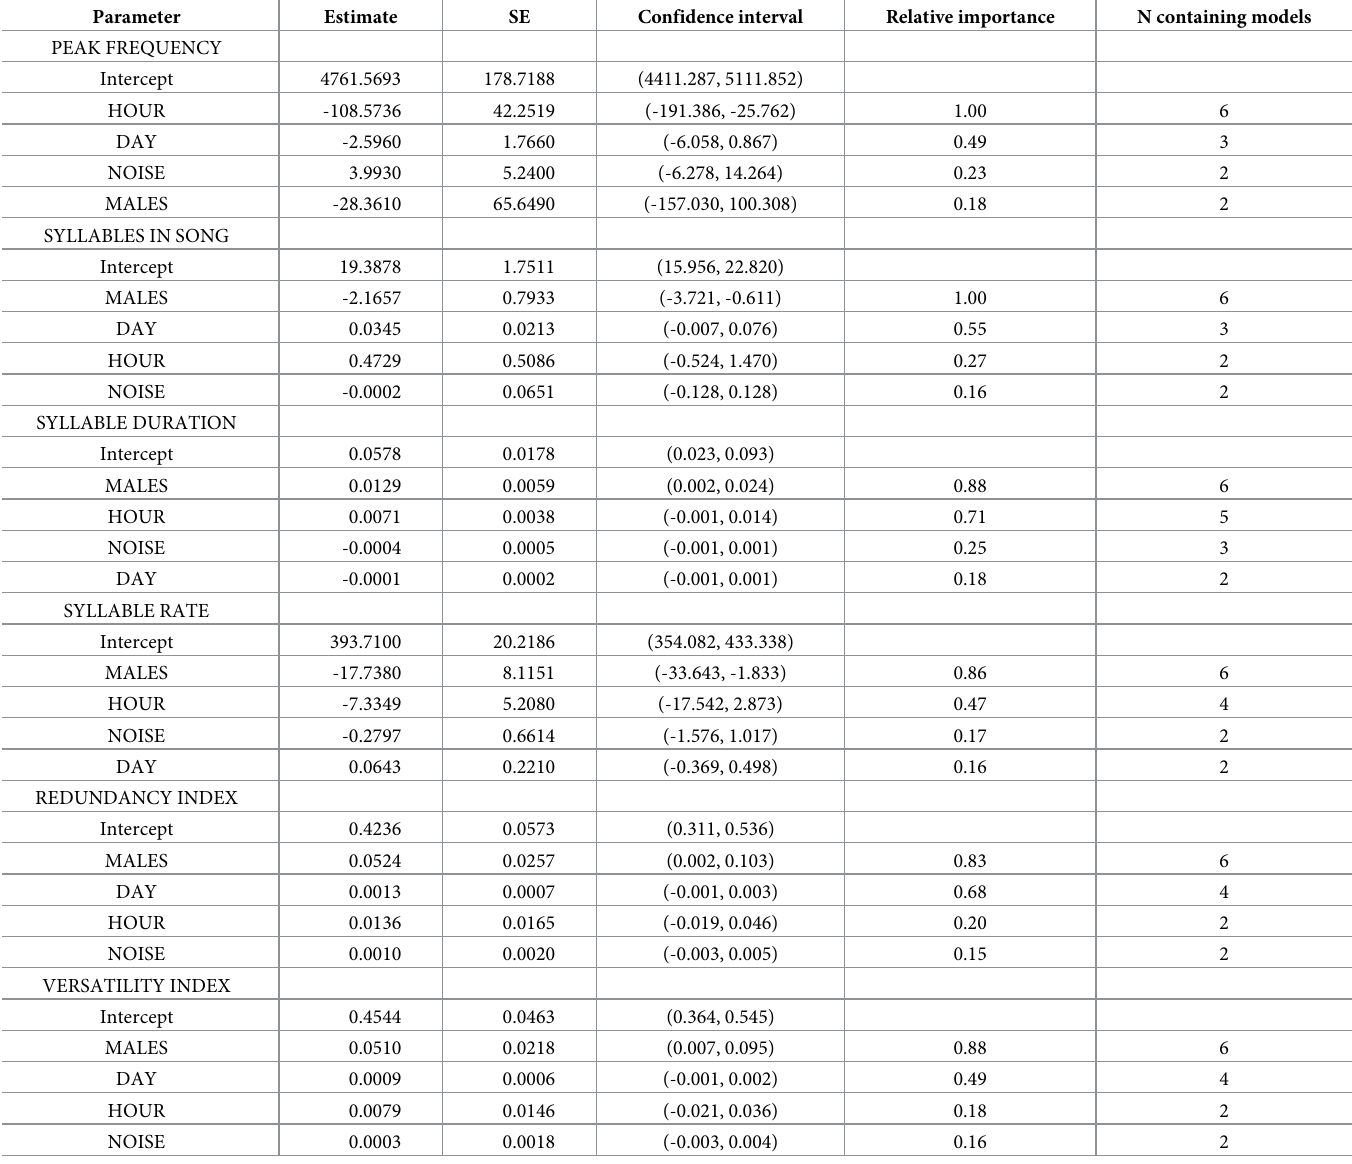
Table 3. Model-averaged estimates of factors describing selected Willow Warbler song